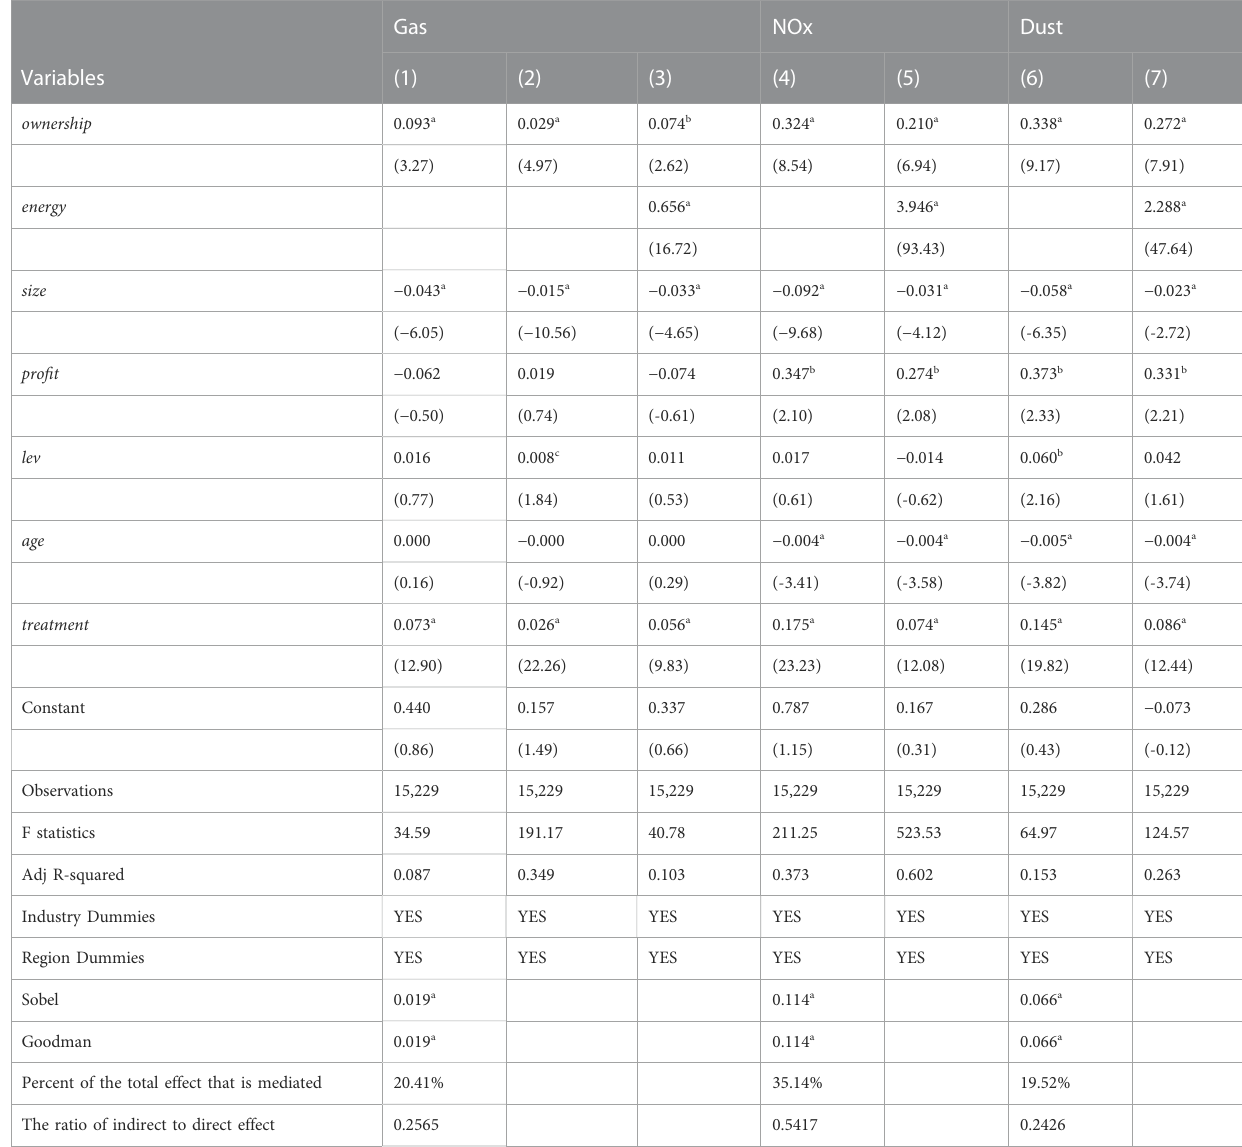
TABLE 2 Mediation effect